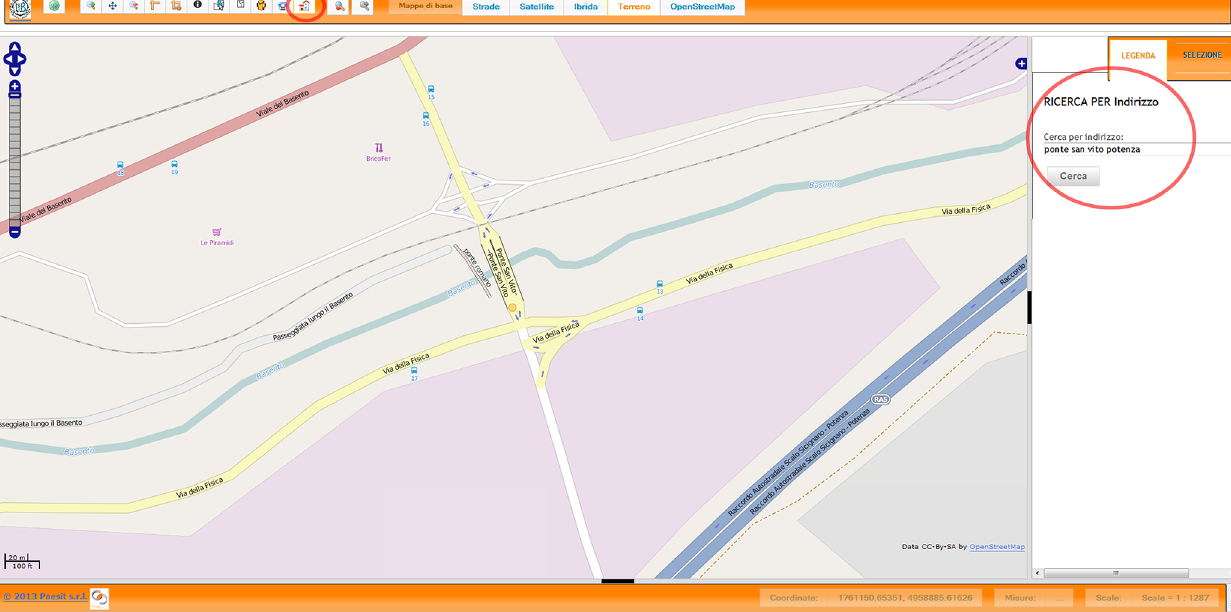
Figure 7. Example of the use of the Geocoding tool: shown is a search for the “S. Vito” bridge in the municipality of Potenza, Basilicata